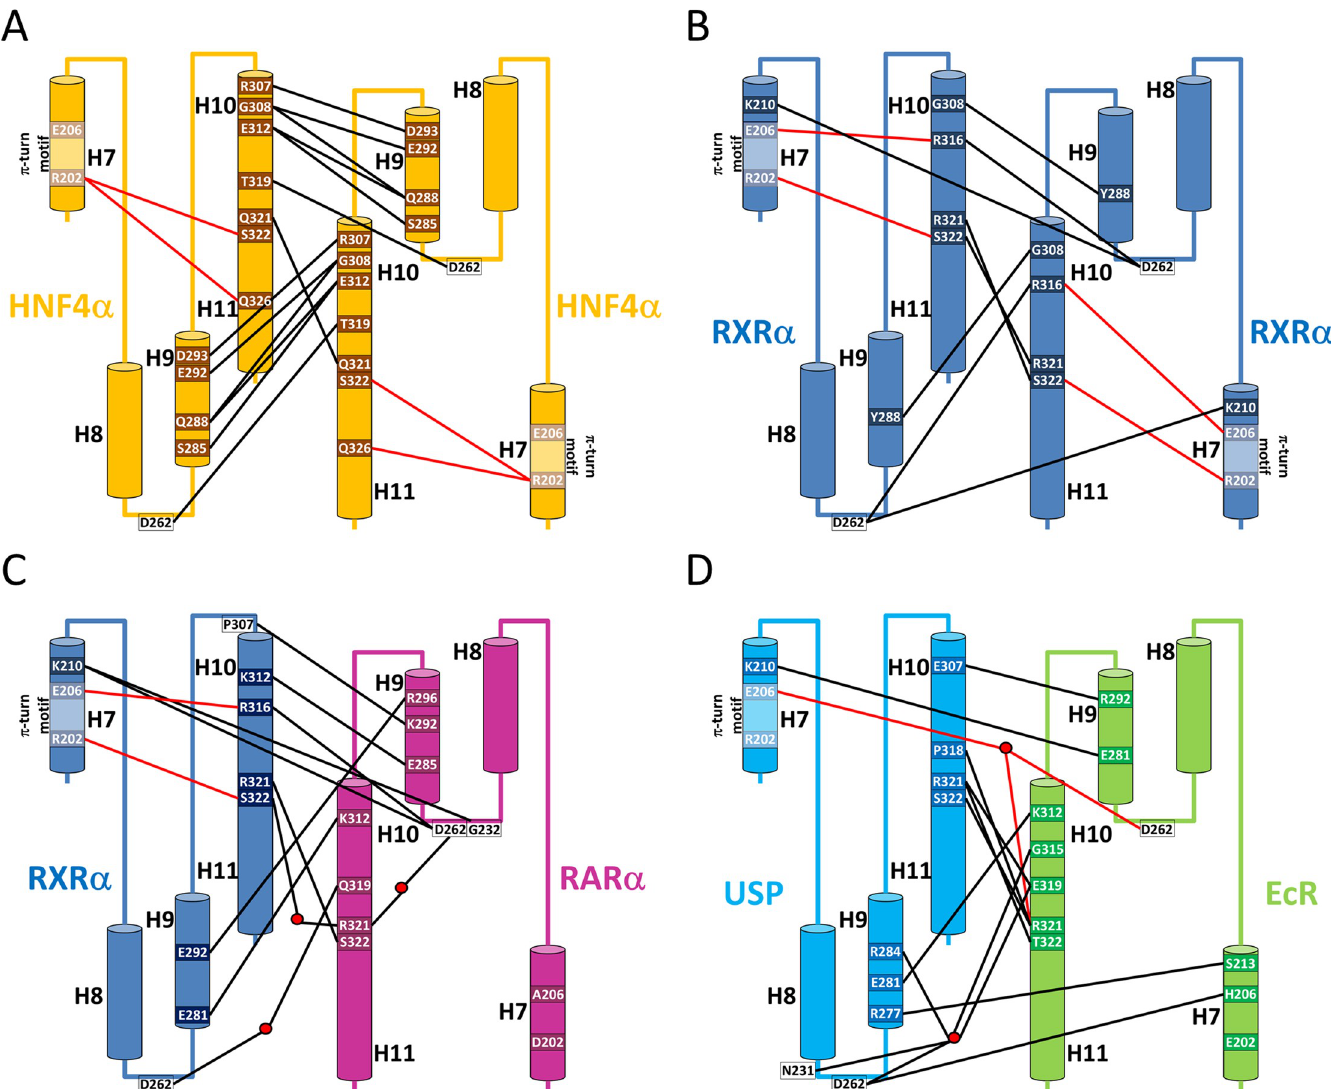
Fig 4. Schematic representation of the dimer stabilizing bonding interactions. The set of α -helices H7 to H11 of each subunit of the LBD dimer is represented by cylinders. Water molecules are shown by red dots. Dimerization bonds between the two LBD subunits are represented by black lines and bonds between residues R202 and E206 of the π -turn motif and residues at the dimer interface are shown by red lines. Shown in the scheme are bonds which are most frequently observed in the majority of the available structures. (A) HNF4 α LBD. The dimer is symmetric and mainly stabilized by cross-contacts between helices H9 and H10. The π -turn contributes in an indirect manner to the dimerization interface through internal bonds with residues of helix H11. (B) RXR LBD. The dimerization is symmetrical, but less stabilizing bonds can be observed as compared to the HNF4 case. Interactions are also more uniformly distributed over the entire interface, but helix H9 is weakly involved in the dimerization interface, whereas the π -turn is directly and strongly implicated. (C) RXR-RAR. The dimer is asymmetrical, and helices H9 are more strongly involved in the dimerization interface. The helix H7 of RXR directly contributes to the dimer interface through its π -turn. There is no contribution of RAR helix H7. (D.) USP-EcR. The interface is asymmetrical, but less asymmetric than for the different heterodimers formed with RXR. Note the unusual role played by helix H7 of EcR in the dimerization process [48]. other subunit. Importantly, the π -turn residues play a crucial role in the stability of the homo- dimer. R202 and E206 are both involved in the dimerization interface. R202 link together S322 (H11) in the same subunit to R321 in H10 of the other subunit. E206 links together R316 (H10) found in the same subunit to D262 located in the loop L8-9 of the other subunit. The lat- ter residue further interacts with K210 located at the C-ter of the π -turn. Altogether, the